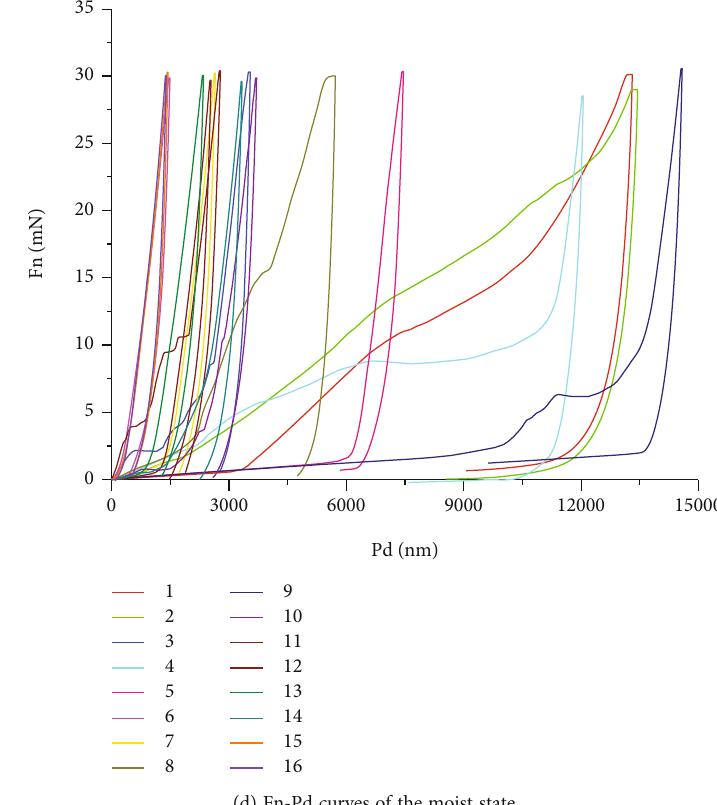
Figure 7: Indentation distribution and force-depth (Fn-Pd) curves of the dry and moist